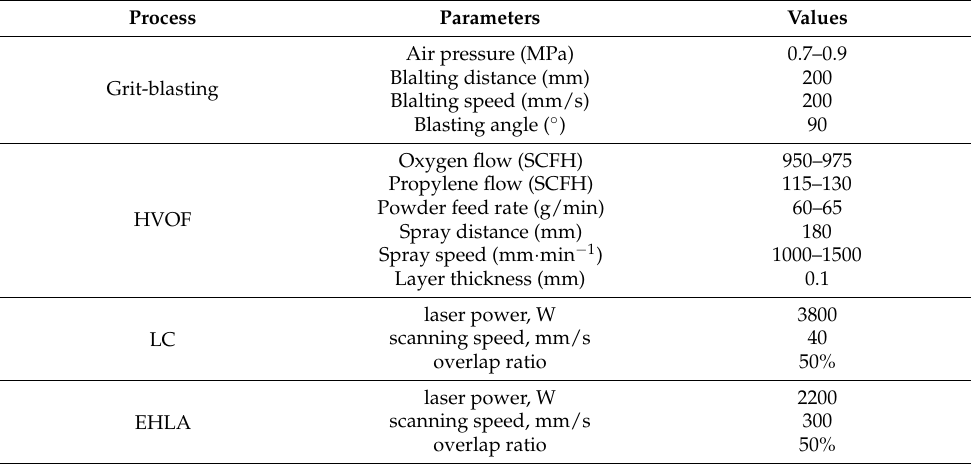
Table 4. Technology parameters of grit-blasting, HVOF, LC and